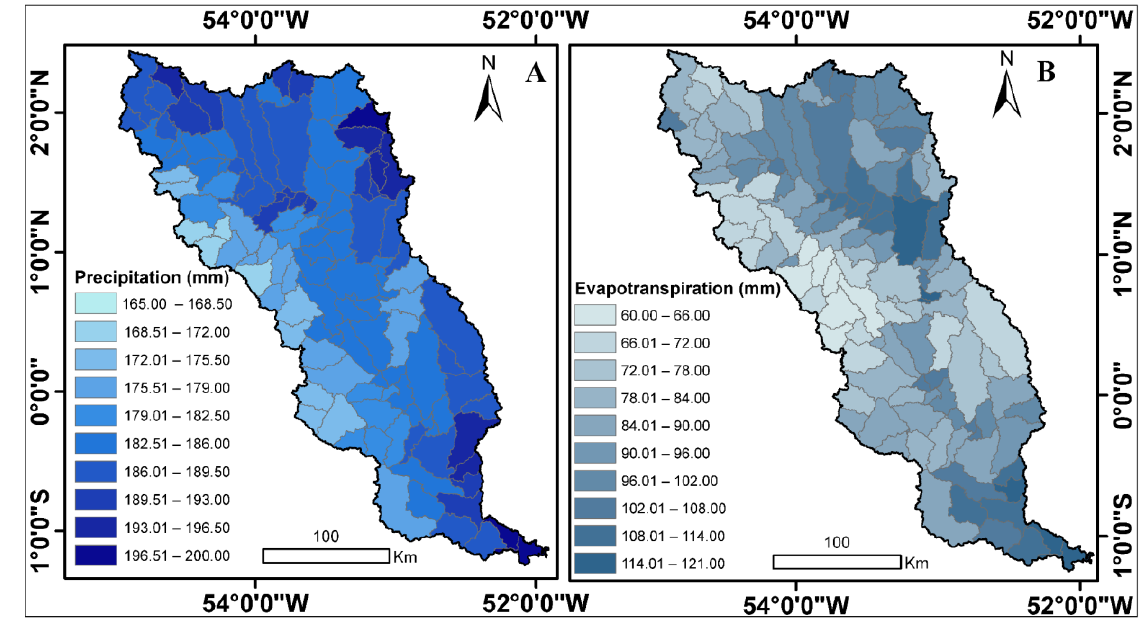
Figure 6. Spatial distribution of precipitation ( A ) and evapotranspiration ( B ) from SWAT simulations of the study area.